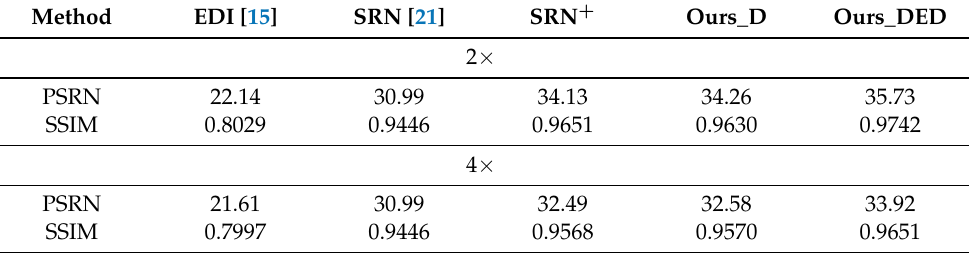
Table 1. Image deblurring results of GoPro in terms of average PSNR and SSIM. SRN and SRN + represent the results of image deblurring without and with low-resolution events, respectively, while Ours_D and Ours_DED represent the results of our method without and with EventSRNet, respectively. This shows that the proposed method outperforms the methods from previous works and image deblurring can benefit from low-spatial resolution events and event-enhancing